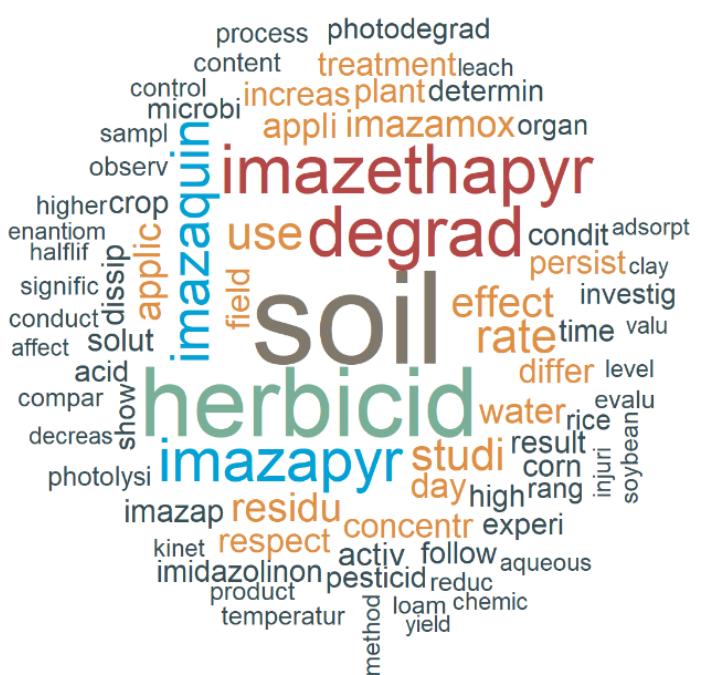
Figure 2. Word cloud prepared using the frequency of terms found in the records selected to obtain imidazolinones’ half-life. The size and color of the terms denote their frequency in the abstracts of the documents.